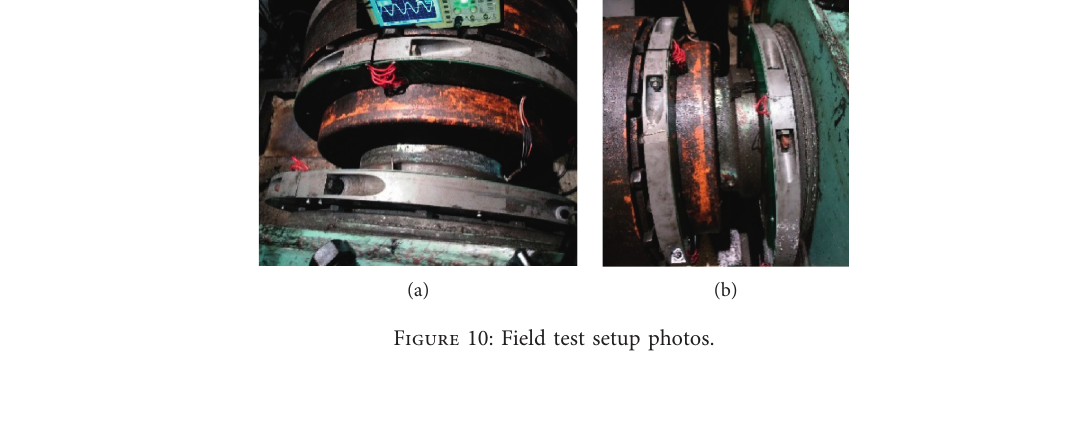
Table 2: Field test data